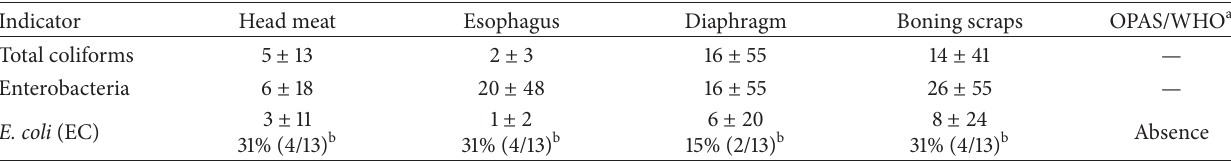
Table 2: Total coliforms, Enterobacteriaceae, and Escherichia coli count averages in comminuted beef produced in a slaughterhouse refrigerator in the state of Mato Grosso, Brazil.